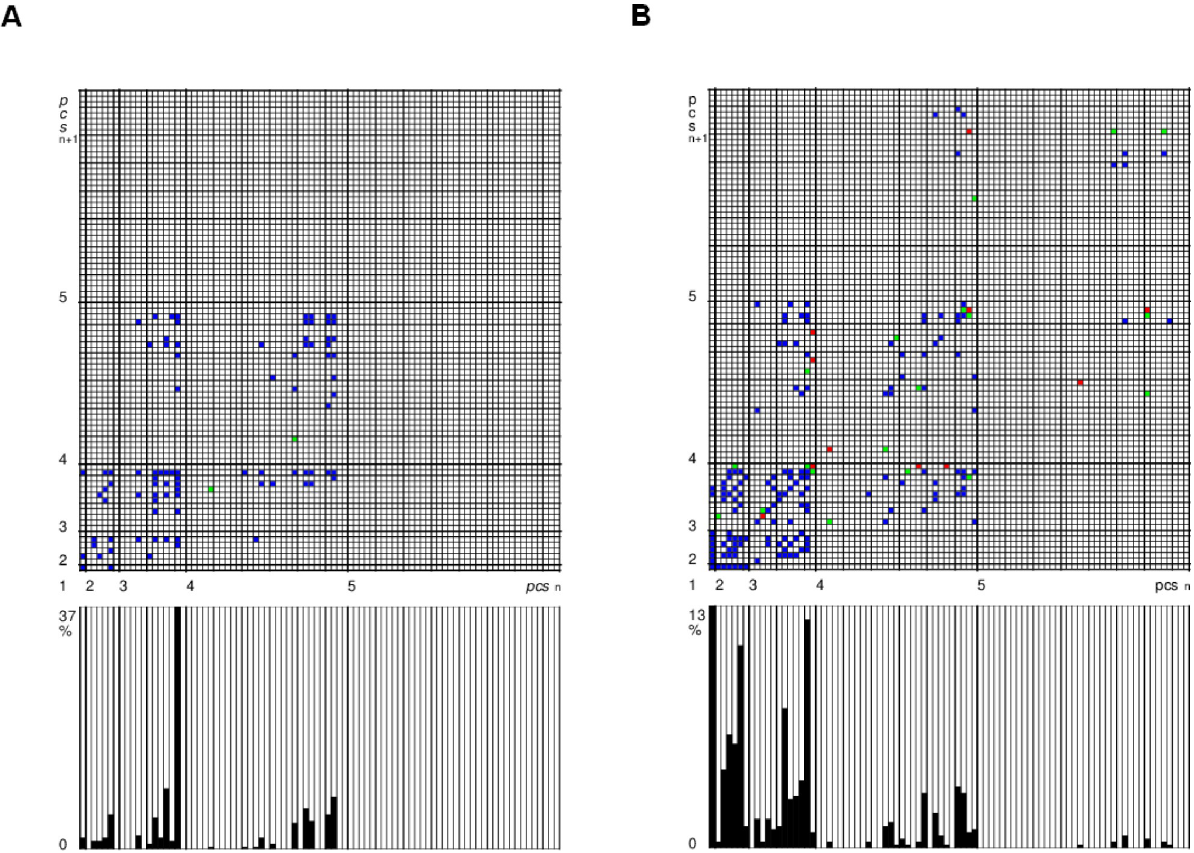
Fig 3. Fingerprint grid diagrams of pcs n - pcs n+1 2-tuples and relative pcs abundances of examined compositional works. [ A: D. Buxtehude 1675 − 76; B: A. Bruckner, 1878; based on vertical pitch set links (tuples of consecutive vertical pitch class sets ) coded as pitch class sets ( pcs ). Consecutive ordered pairs of pcs both being extentionally diatonic (incl. intentionally chromatic) ( blue ); both pcs being extentionally chromatic (i.e. non-diatonic) ( red ); a pcs being extentionally diatonic (incl. intentionally chromatic), followed or preceded by a pcs being extentionally chromatic (i.e. non-diatonic) ( green ). Bar charts of relative abundances of occurring pcs from pcs 1–1 to pcs 5–38 at the bottom.] Symphony no. 5 Symphony no. 5.